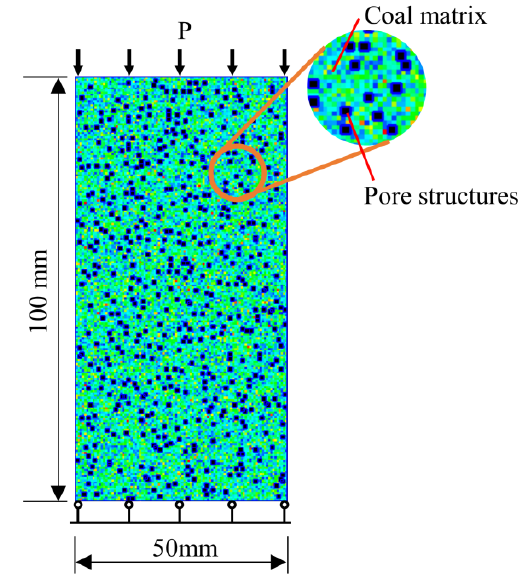
Figure 3. Numerical simulation model.